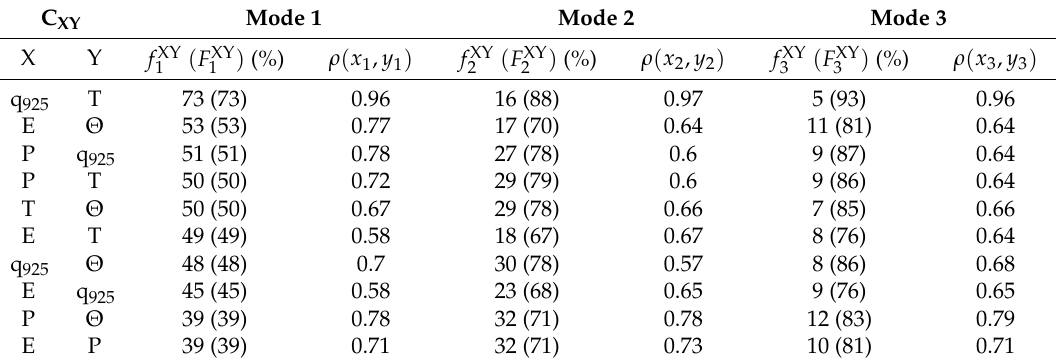
Table 1. Three leading MCA-modes of all possible covariance matrices C XY . Fraction of relative ( f XY cumulative square covariance ( F XY ), and simultaneous correlation between MCA-series, ρ ( x k , y k ) . k Pairs of variables are sorted according with the value of the first